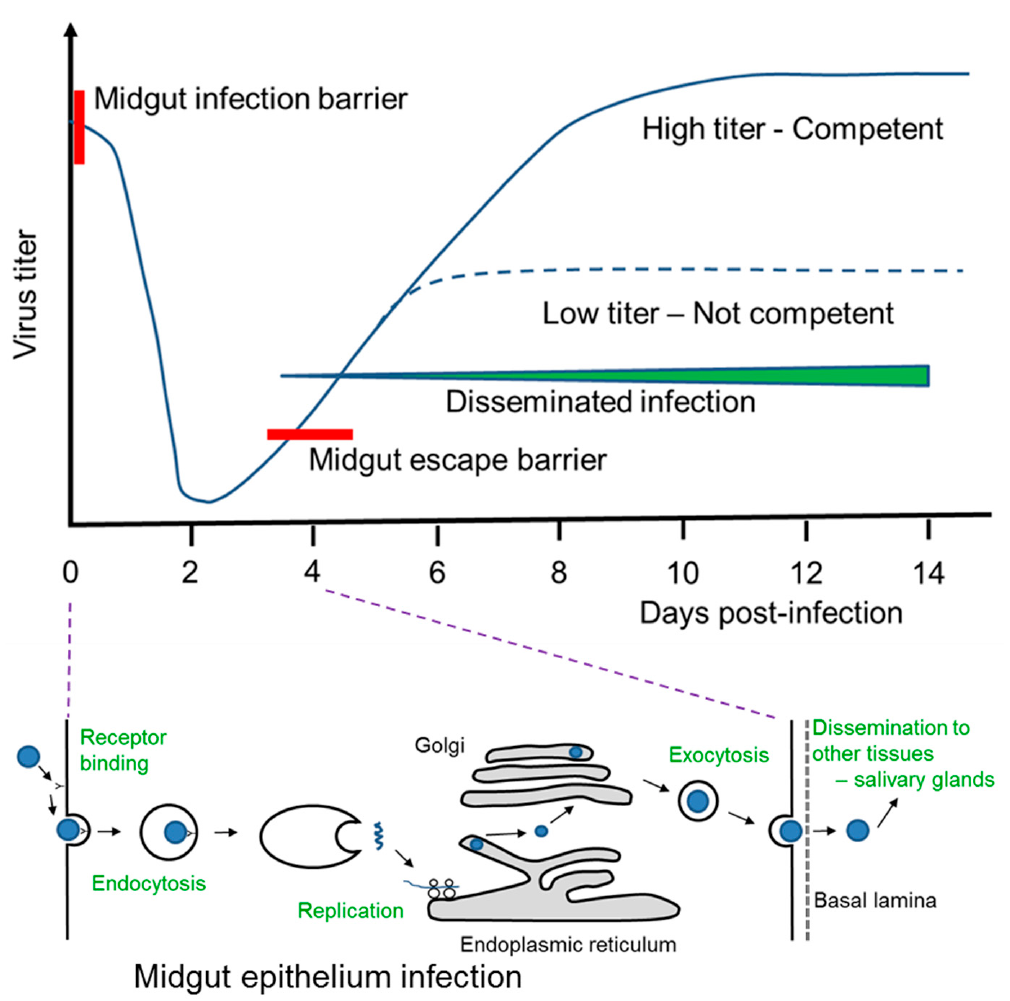
Figure 2. DENV infection and replication cycle in A. aegypti . Compiled from [69,79,83,84]. Following ingestion of an infected blood meal, the time required for a susceptible mosquito host to be competent for oral transmission of the virus to another human host is defined as the extrinsic incubation period (EIP) [67]. The length of the EIP is dependent on multiple factors, including genotypes of both mosquito and virus, as well as environmental factors such as the prevailing temperature and the larval rearing conditions. Following ingestion, virus titer drops considerably over the next ~24–48 h (termed as the “eclipse” period) as endocytosis and replication are initiated in the midgut epithelia (Figure 2) [83]. This time period is likely the most critical for determining whether a given mosquito will eventually become competent to transmit virus. That is, for example, in Aedes albopictus C6/36 cells, DENV has been shown to successfully bind to the cell membrane and endocytose within 5–7 min following infection, and to colocalize with low pH vesicles like lysosomes by 30 min post-infection [82]. Following replication in a susceptible host, exocytosis occurs and the virus is able to disseminate to and replicate in other tissues, most importantly the salivary glands. The EIP is typically considered to be ~7–14 days, but has been shown to take only ~4 days with some mosquito/virus interactions [84]. Multiple tissues have been linked with barriers to arbovirus infection in mosquitoes [17] that not only include direct cellular activities but also physical barriers such as the basal lamina [84,85]. Of note, at this point no direct evidence exists for a salivary gland barrier to DENV infection in A. aegypti , so the prevailing conclusion is that if the virus successfully infects the midgut epithelium and escapes into the hemocoel, that mosquito will become competent